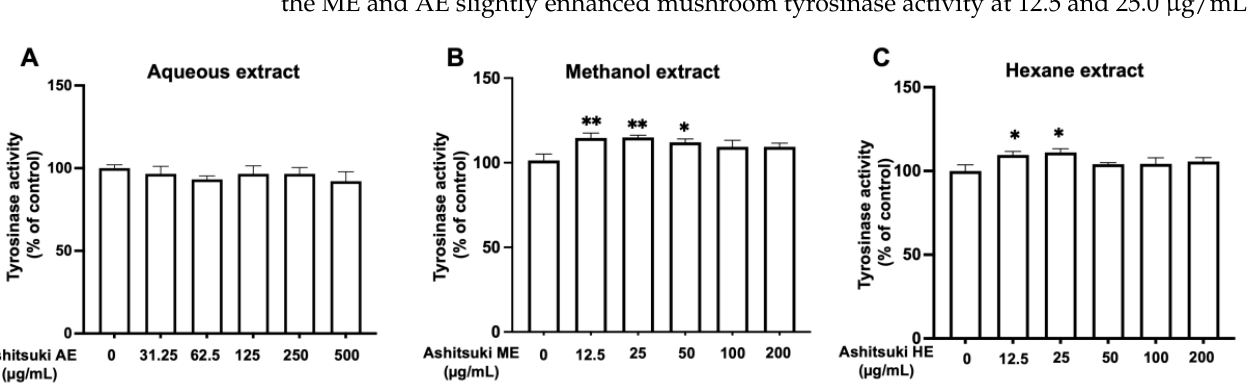
Figure 4. Effect of N. verrucosum ( ashitsuki ) extracts on tyrosinase activity. Effect of N. verrucosum aqueous ( A ), methanol ( B ), and hexane ( C ) extracts on monophenolase activity was measured. Results are represented as percentages of the control; the data are shown as mean ± SEM of three separate experiments. * p < 0.05, ** p < 0.01 versus the control group.